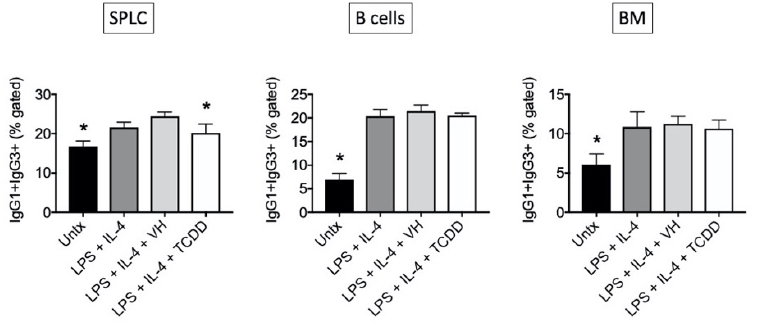
Figure 11. TCDD inhibited percentage of cells co-expressing IgG1 and IgG3. SPLC, B cells or BM cells were treated with VH (0.01% DMSO) or TCDD (30 nM) for 30 min then were stimulated with LPS + IL-4 (5 µ g/mL + 10 ng/mL). Cells were incubated for 1, 2, 3 or 4 days then stained for CD19, B220, CD5 IgG1 and IgG3. Cells were gated on live single lymphocytes then the double positive population for IgG1 and IgG3 was calculated on day 4 only. Bars represent mean ± SD from triplicate samples. Untx, untreated; VH, vehicle. * p < 0.05 as compared to respective LPS + IL-4 + VH control within cell type. Data were obtained from one of the representative in vitro experiments in which IgG1 and IgG3 were evaluated on CD19+ and B220+ cells.